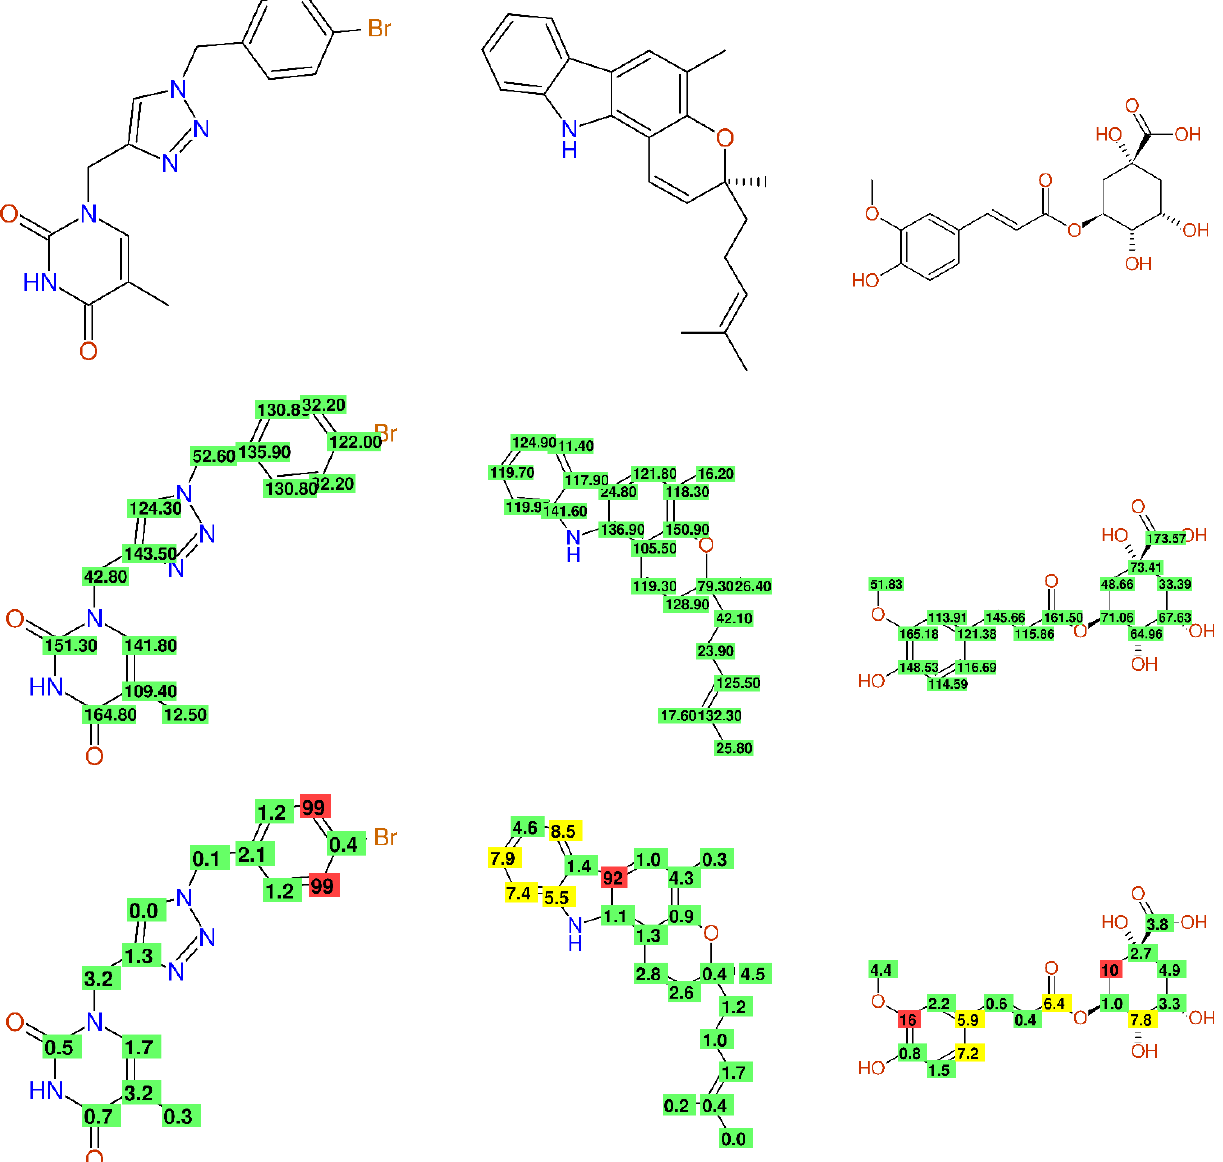
Figure 5. 13 C-NMR data of compound 13 from [40] ( left ), compound 3 (mahanimbine) from [38] ( middle ), and compound 5 from [39] ( right ), together with the differences between the experimental and predicted chemical shift values. Differences larger than 99 ppm are always shown as 99 ppm.